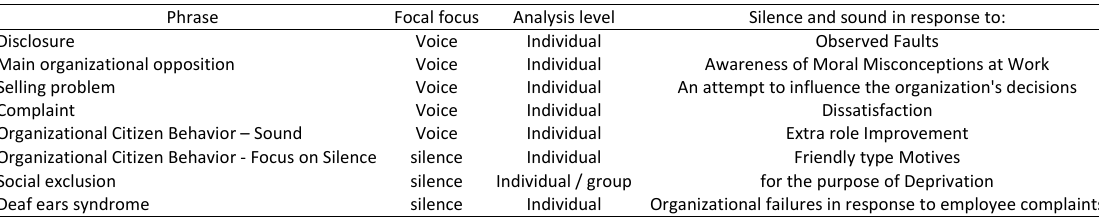
Table 2: The second wave of evolution of organizational silence (Edwards et al ., 2009) Table 2. The second wave of evolution of organizational silence (Edwards et al ., 2009 )